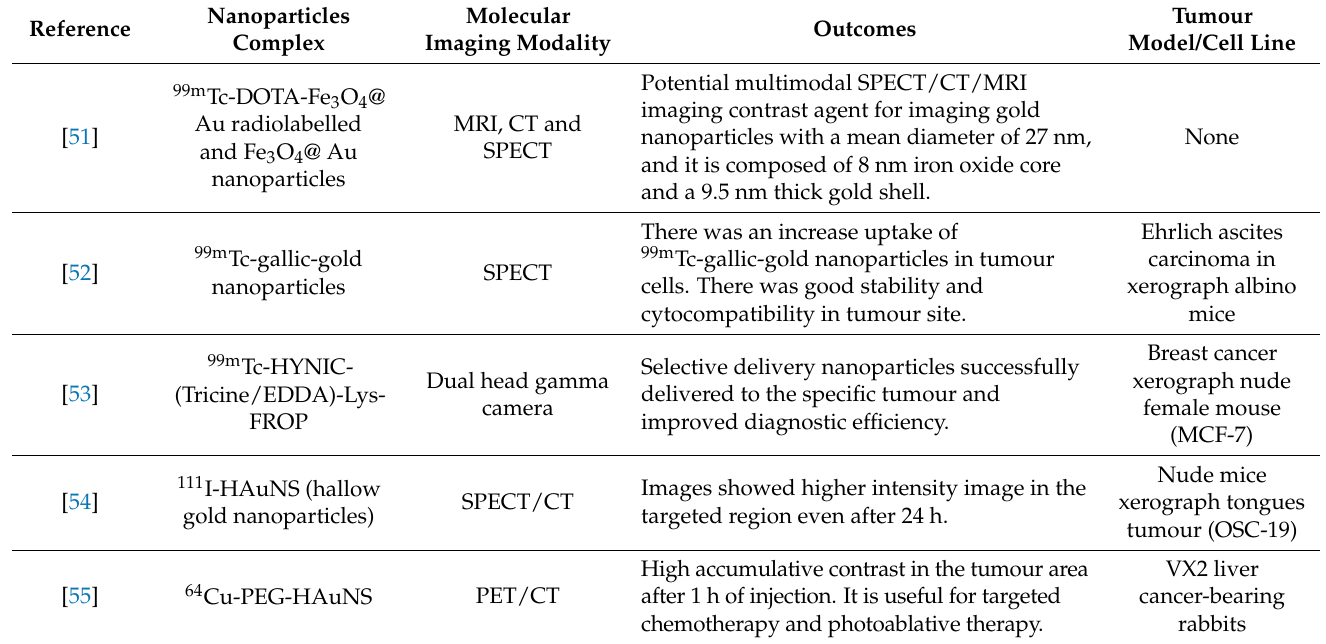
Table 7. Recent applications of gold nanoparticles in molecular